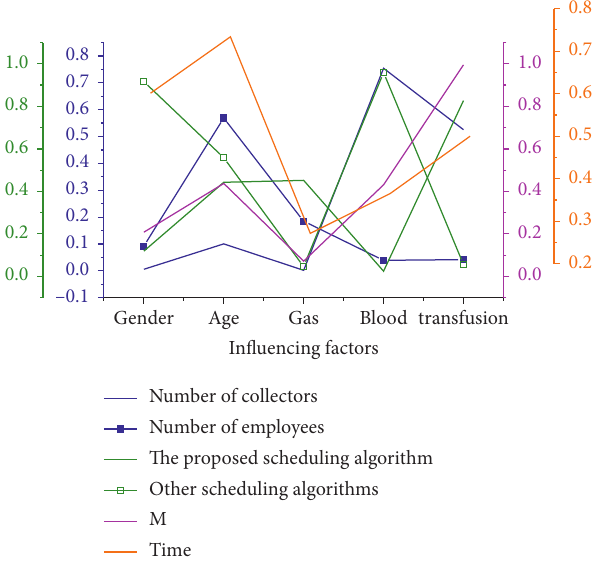
Figure 4: Trend of the composite indicator M.